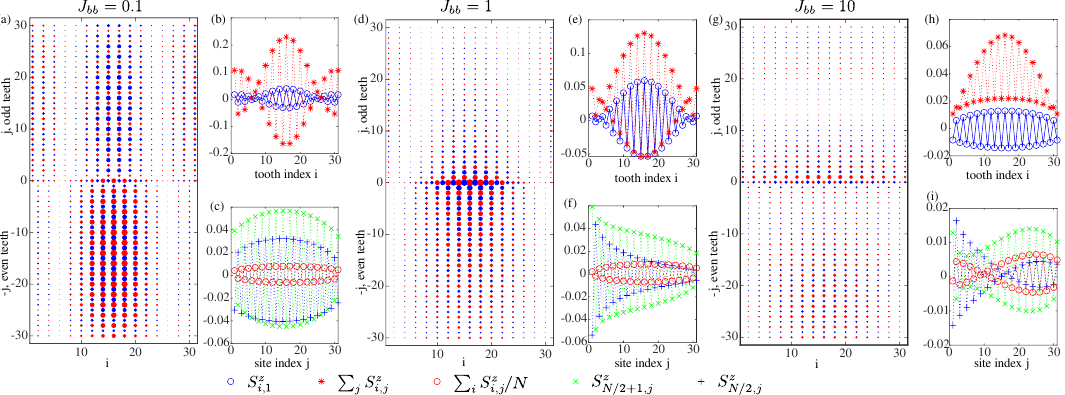
Figure 16: (Color online) Same as Fig.11 but for odd L = N = 31. Here we plot the difference in magnetization between the lowest energy state in the sector of = 3 / 2 and the ground-state in the sector of S z S z tot spect to panels (a) and (d), the size of circles were enlarged by a factor of